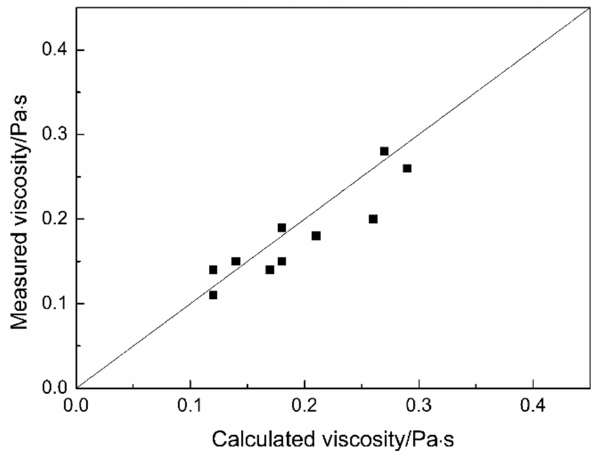
Figure 2: Calculated viscosities using MD simulations against experimental